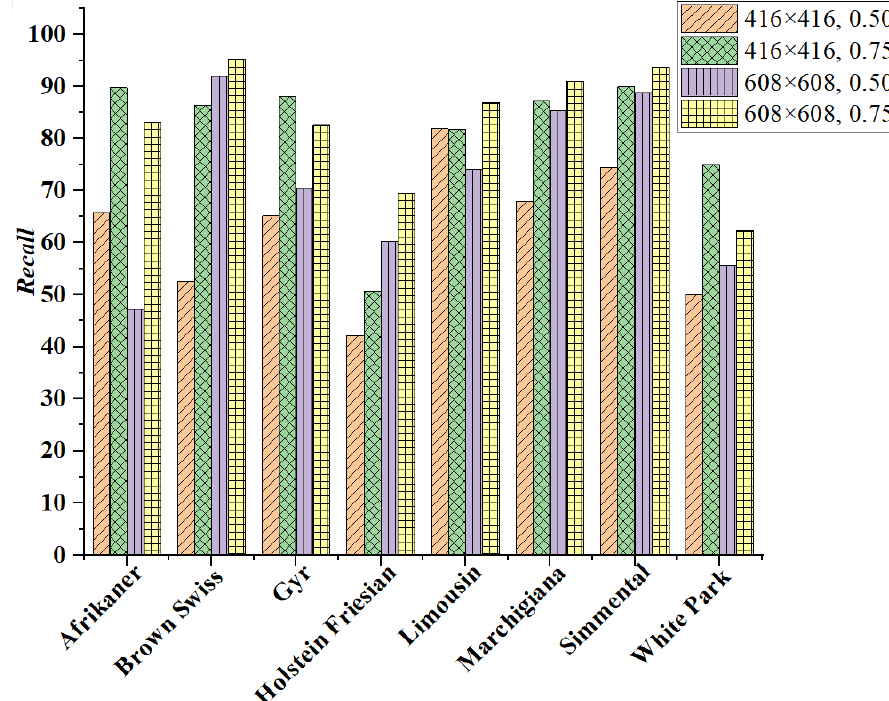
Figure 17. Class-wise precision.